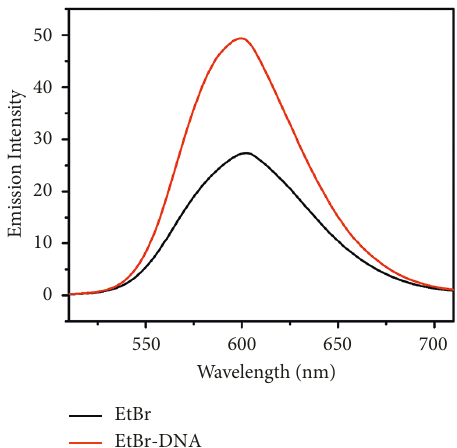
Figure 5: Fluorescence spectra of EtBr alone and